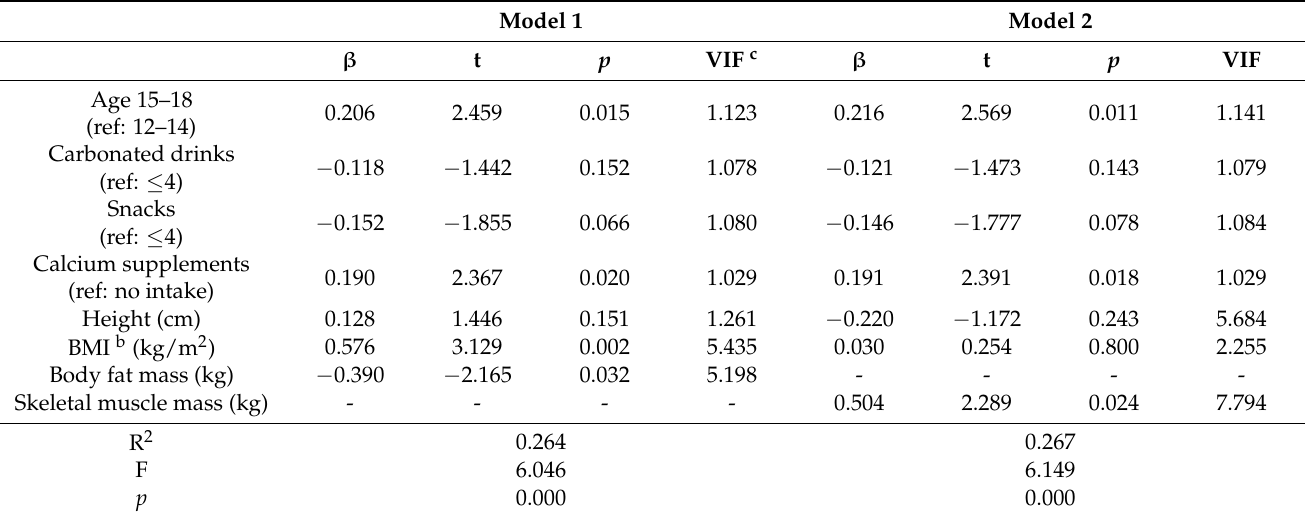
Table 4. Predictors of BQI a ( n =